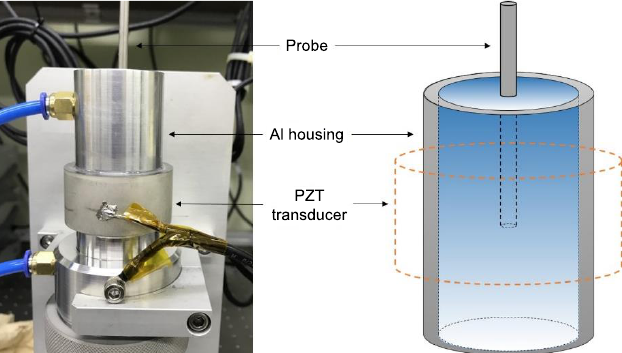
Figure 3. Photograph and schematic of the setup used to measure the acoustic pressure.